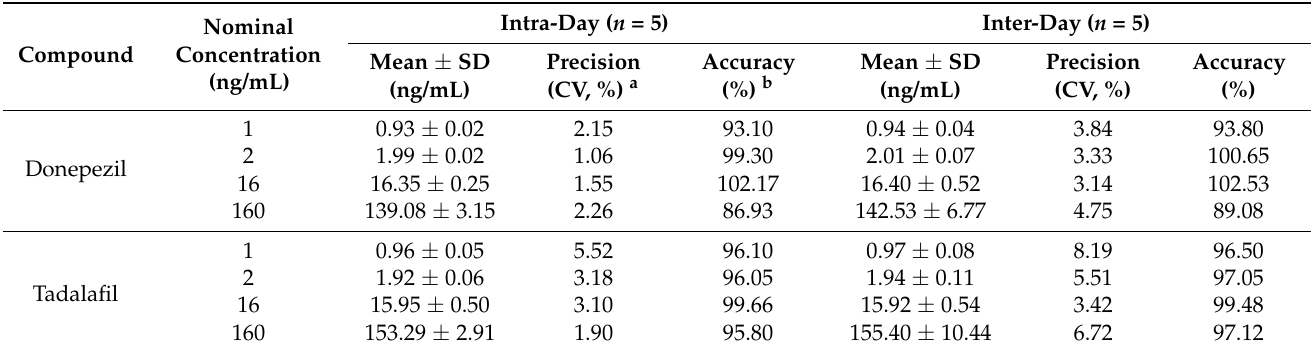
Table 1. Intra- and inter-day precision and accuracy of the LC-MS/MS method for determining donepezil and tadalafil concentrations in rat plasma.